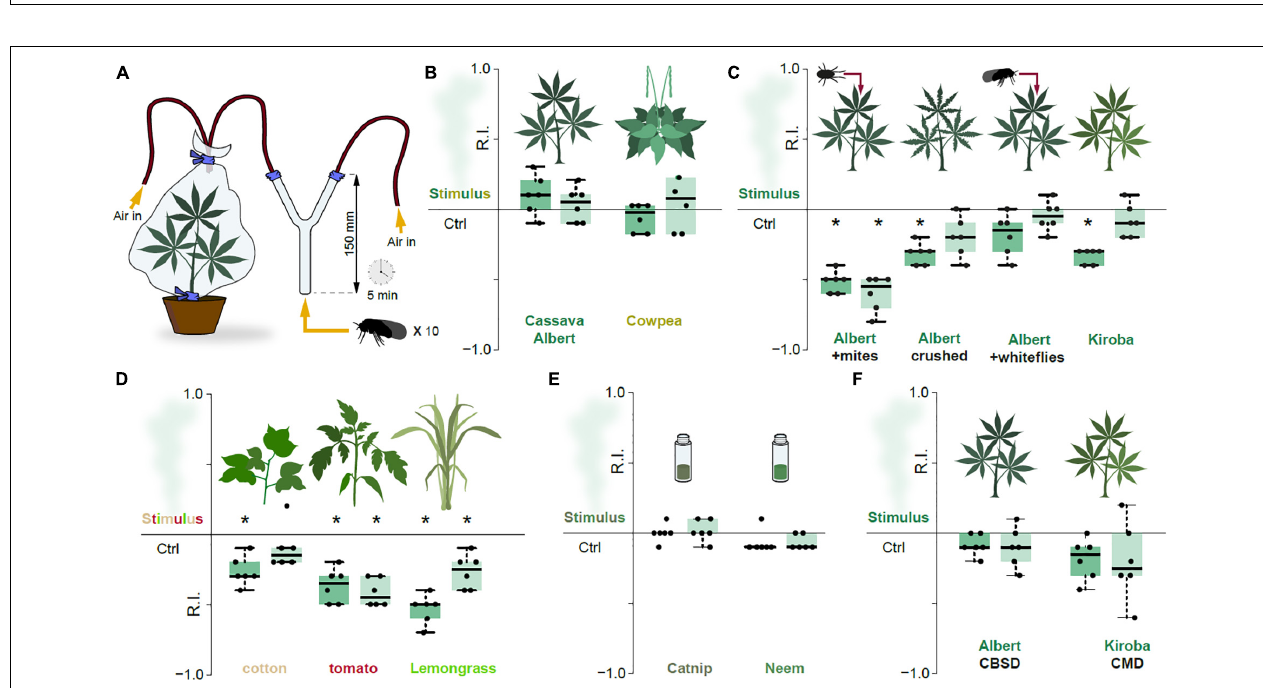
FIGURE 3 | Repulsion is the basis for odor-guided response in the cassava whitefly. (A) Experimental set-up of the two-choice odor-guided behavior assays with 20 male and 20 female adult whiteflies with six repeats for each plant type. (B) Response indices (RI) obtained from the cassava whiteflies exposed to volatile chemicals from suitable host plants. The edges of the boxes are the first and third quartiles, thick lines mark the medians, and whiskers represent data range. (C) RI obtained from the cassava whiteflies exposed to volatile chemicals from suitable host plants mechanically damaged cassava plants. (D) RI obtained from the cassava whiteflies exposed to volatile chemicals from alternative host-pants. (E) RI obtained from the cassava whiteflies exposed to volatile chemicals from insect repellent essential oils, catnip and neem. (F) RI obtained from the cassava whiteflies exposed to volatile chemicals from virus infected cassava plants. For all Boxplots, the dark green boxes represented the preference indices of the male whiteflies while the light green boxes represented the preference indices of the female whiteflies. The preference was tested with one-sample Wilcoxon test, theoretical mean 0. *Denotes significantly different from 0; p < 0.05.